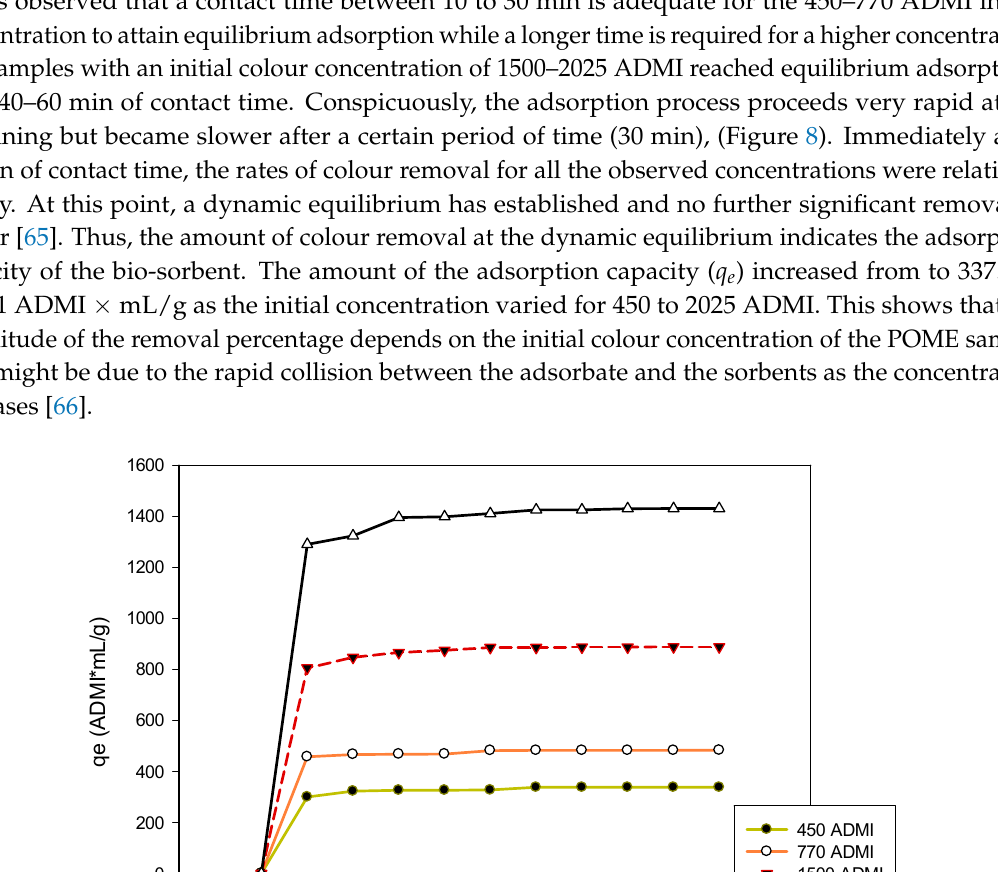
Table 7. Important constants of the isotherm models and fitness correlation.